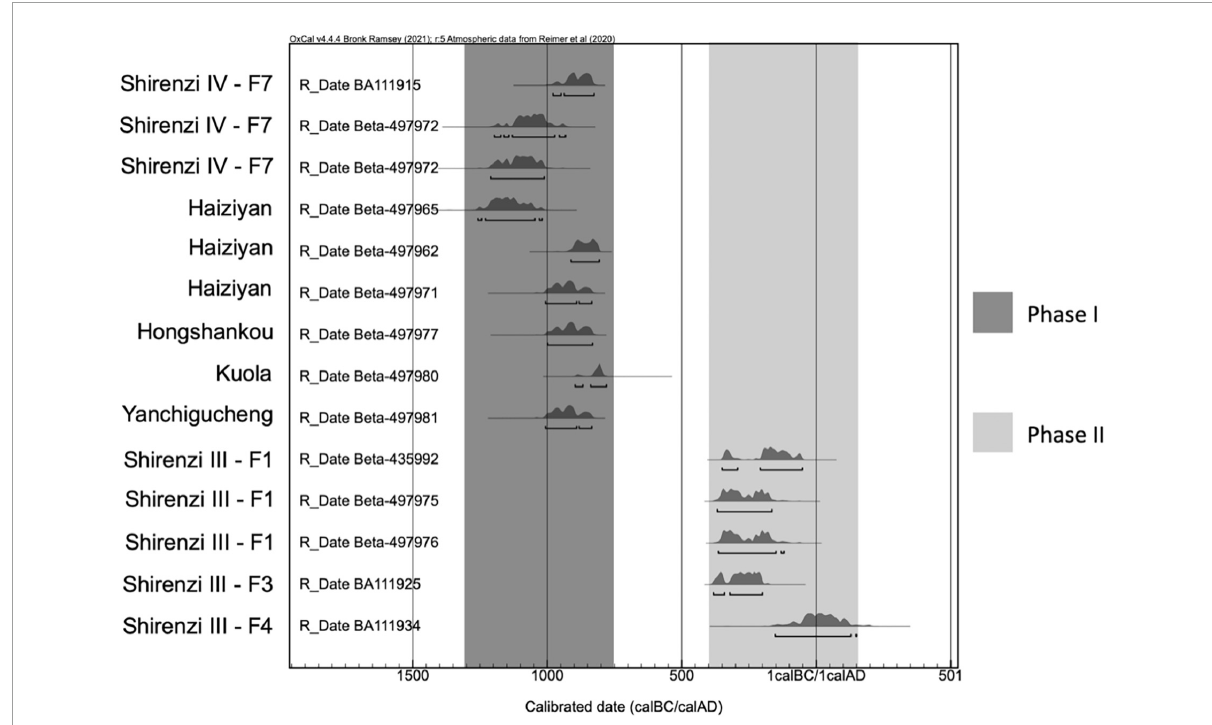
FIGURE1 Accelerator mass spectrometry (AMS) radiocarbon results generated by this study together with previously published 14 C measurements as detailed in Supplementary Table 1 . These results confirm the two occupational phases of the eastern Tianshan complexity (ETC) sites.